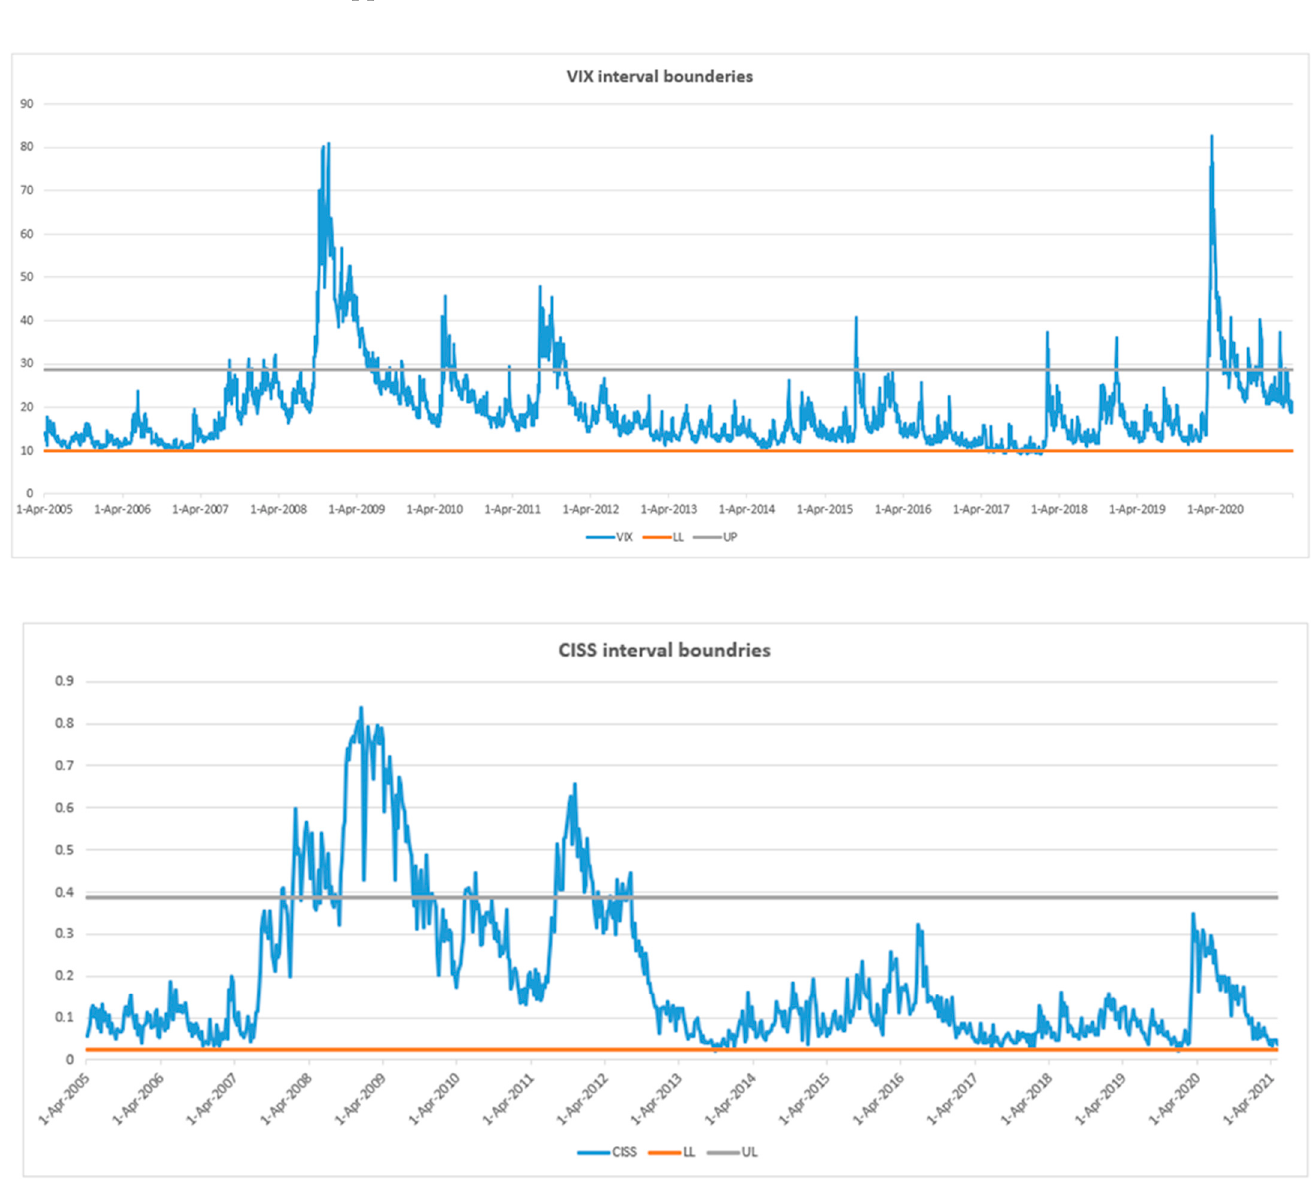
Figure A5. The Evolution of the VIX and CISS Index.